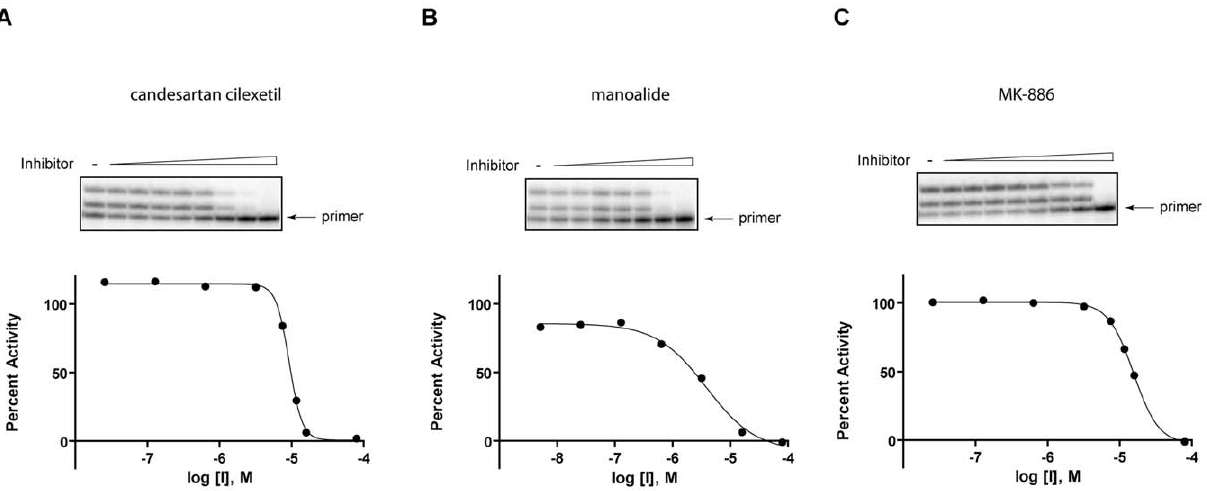
Figure 5. Dose-response activities of (A) candesartan cilexetil, (B) manoalide, and (C) MK-886 on adducted DNAs. Representative data from three independent experiments are shown. The gels shown on the top panel were used to generate dose-response curves shown on the bottom panel.